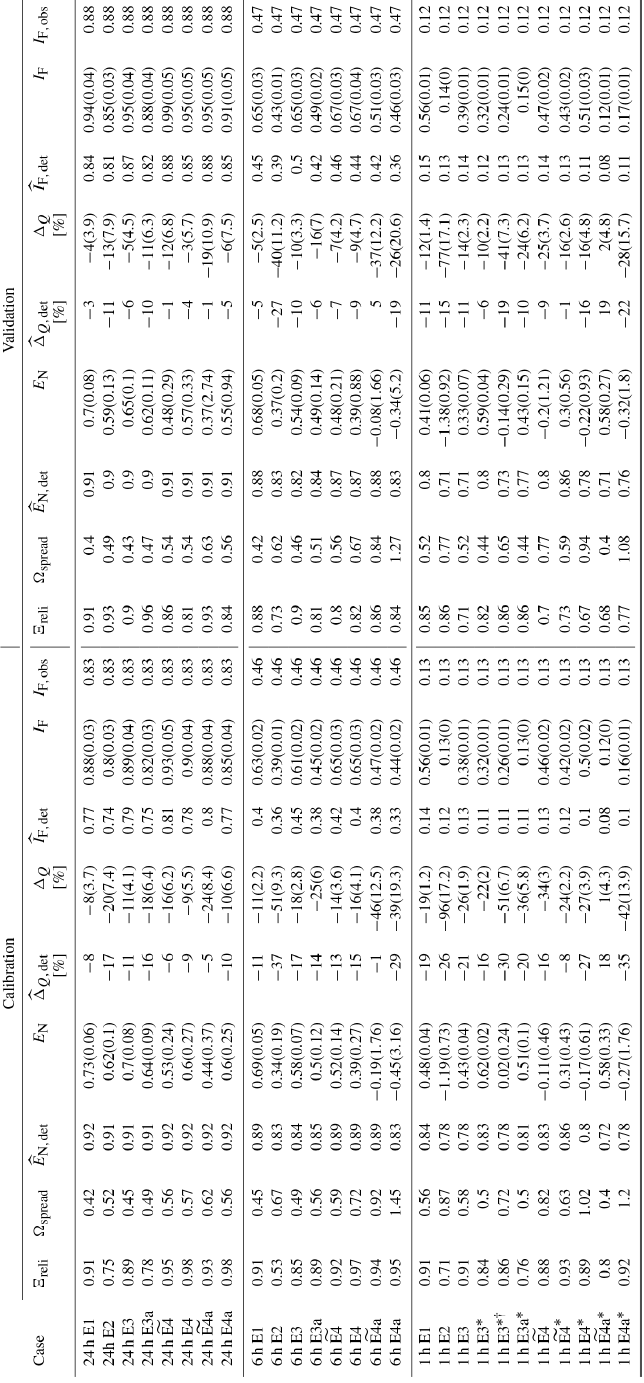
Table B2. Maimai: summary of the predictions in the calibration and the validation period made with error models E1–E4 for different temporal resolutions of the hydrological data. Values are medians (and standard deviation) of the quality indices of the deterministic model output for the maximum posterior parameters, as well as those of 500 streamflow realisations produced with the full posterior parameter distributions. Recall that smaller values of (cid:52) reli and (cid:127) spread indicate better